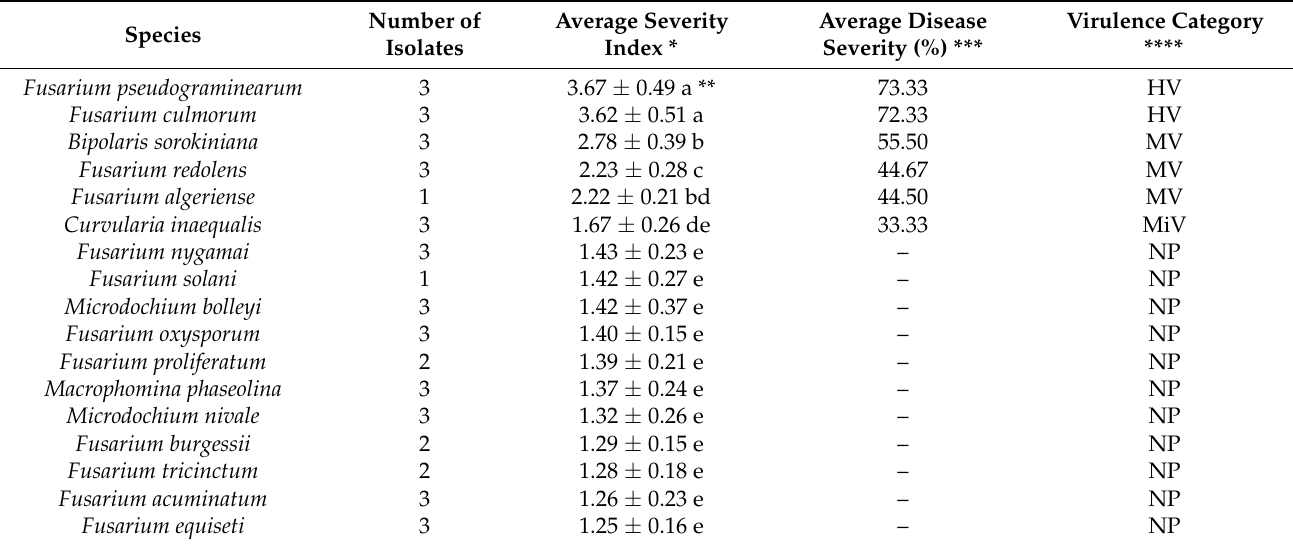
Table 2. The pathogenicity of the fungal species identified in the present study. Number of Species